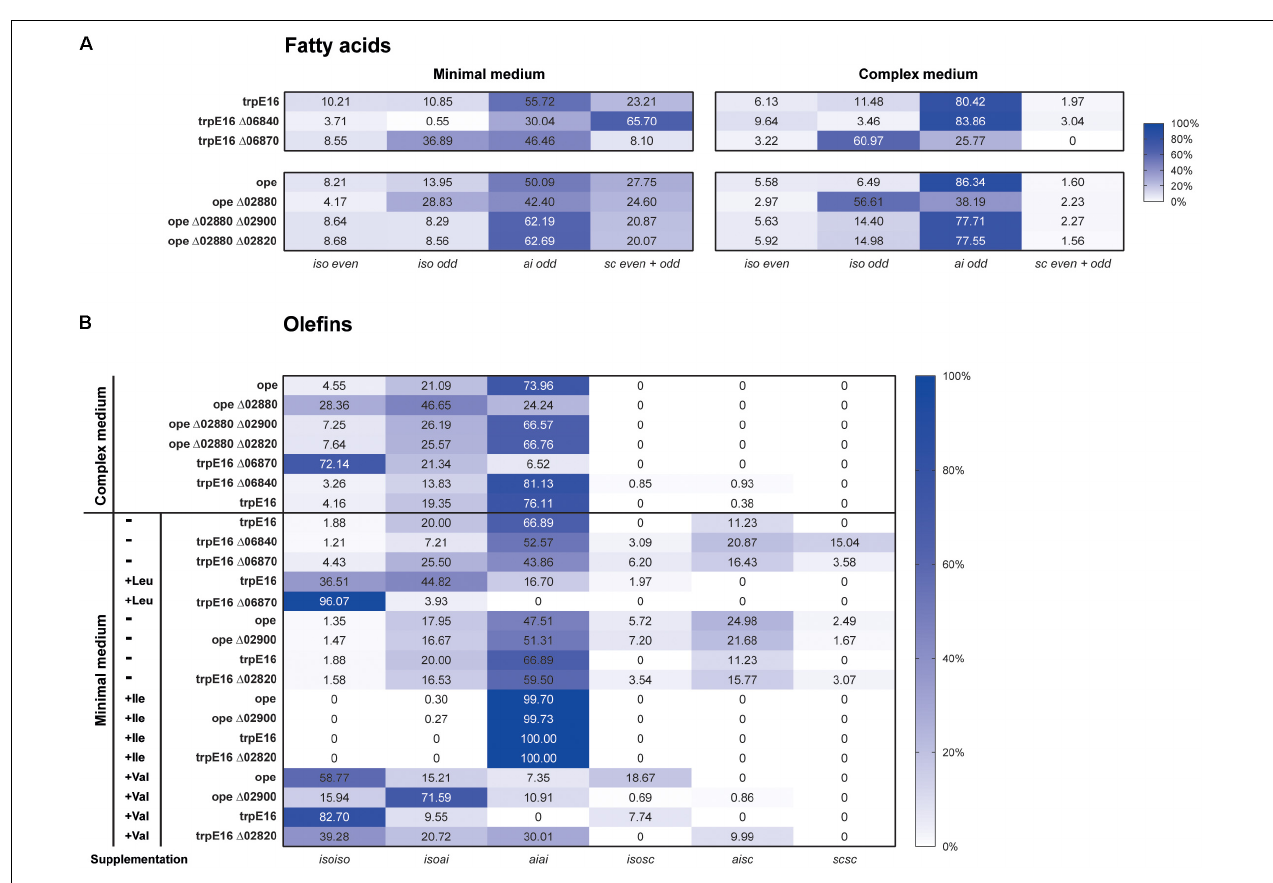
FIGURE 6 | Distribution of fatty acid and olefin isomers in M. luteus mutant strains. (A) Fatty acids profile of selected mutants of the BCAA degradation pathways grown in minimal and complex medium. (B) Distribution of olefin isoforms in selected mutants of the BCAA degradation pathways grown in complex and in minimal medium without (–) and with (+) supplementation with 4 mM leucine, valine or isoleucine. Standard deviations did not exceed 4% except for ope in complex medium, which was less than 10%.